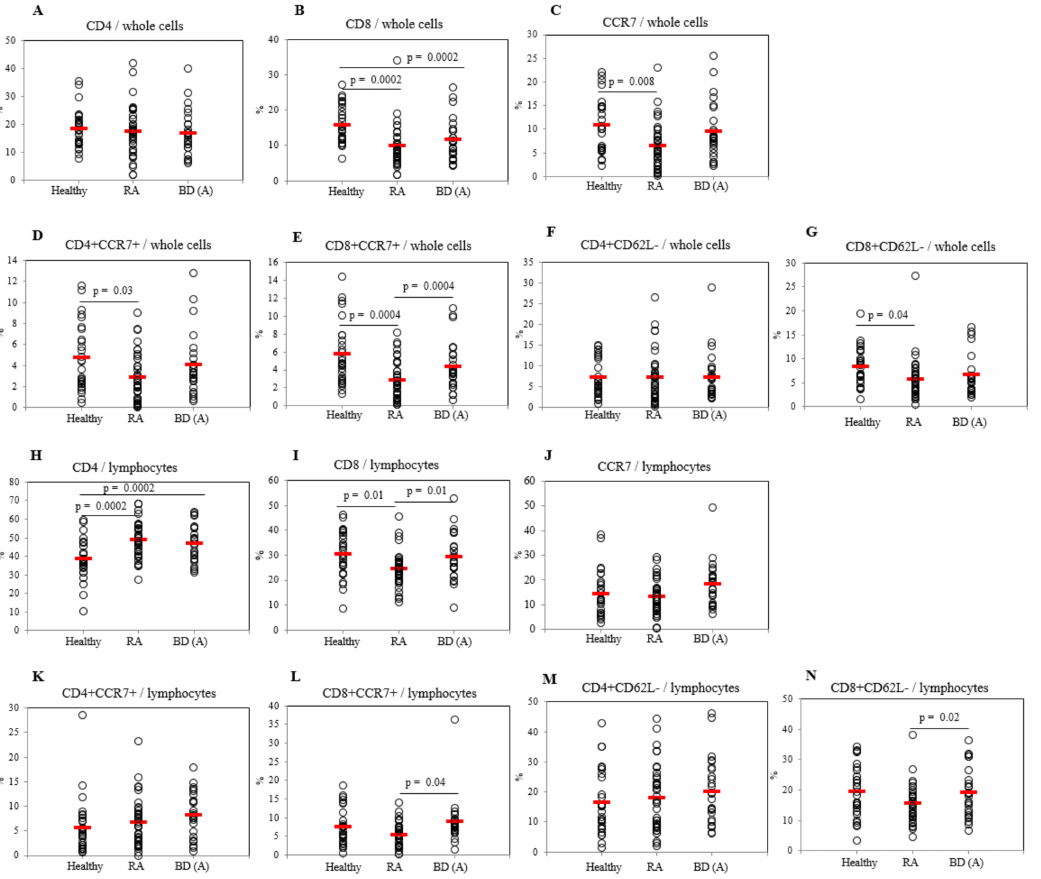
Figure 2. Frequencies of CD4 + ( A ) and CD8 + ( B ) cells with CCR7 + ( C–E ), CD62L- ( F,G ) cells in whole cells and in lymphocytes ( H–N ) of healthy controls (HC), rheumatoid arthritis (RA), and active Behçet’s disease (BDA) patients. Isolated peripheral blood leukocytes (PBL) were subjected to FACS analysis by surface staining. Results were obtained from 28 HC, 36 patients with RA, and 25 patients with